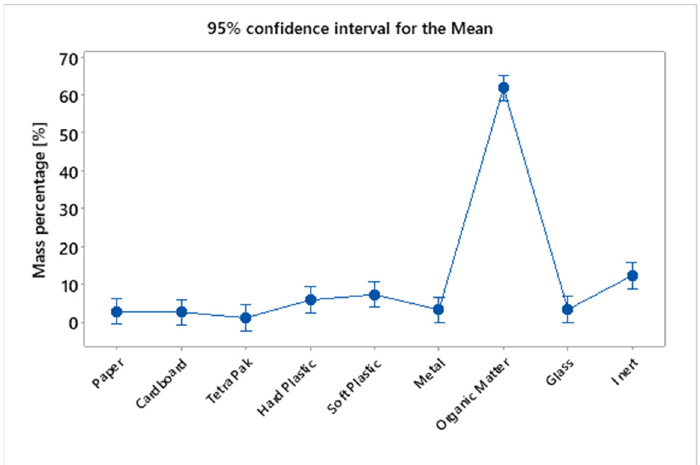
Figure 18. Mass percentage of MHSW fraction materials in a 95% confidence interval for the statistical analysis of gravimetric data of MHSW in the city of Belém-Pará-Brazil on 18 October 2021, 20 October 2021, 27 October 2021, and 29 October 2021.